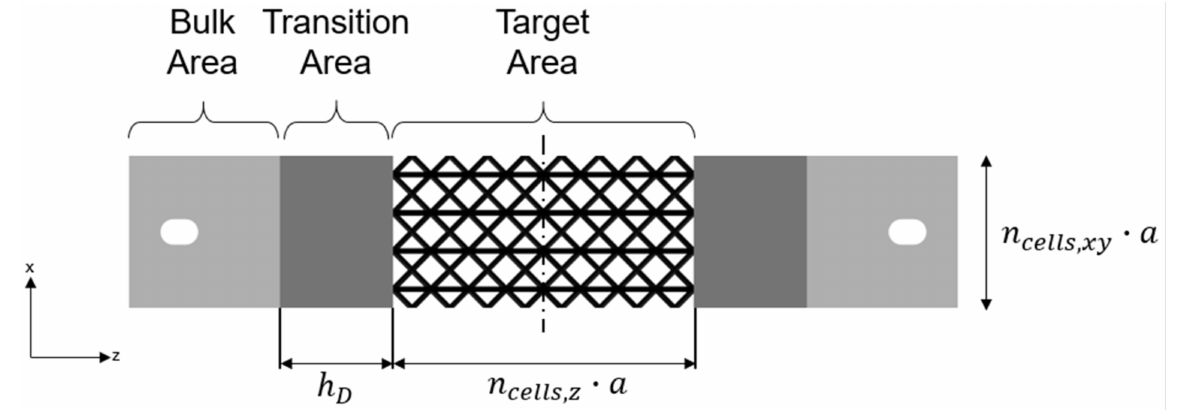
Figure 2. Sample design—Example of f2ccz lattice